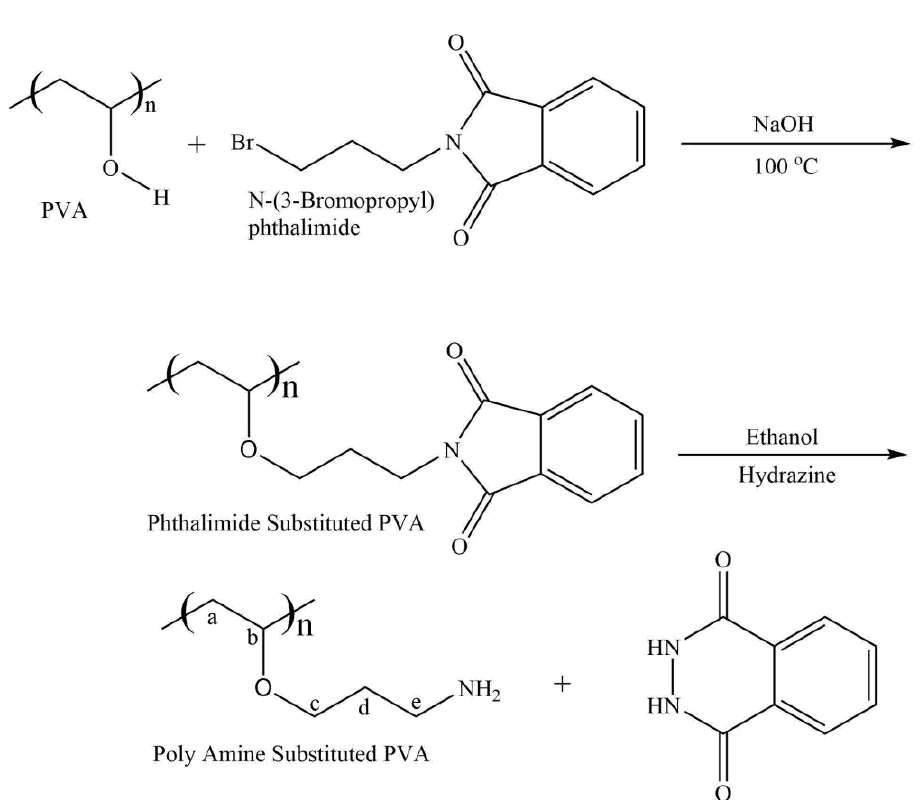
Figure 1. Chemical synthesis of propylamine-substituted polyvinyl alcohol (PVA).